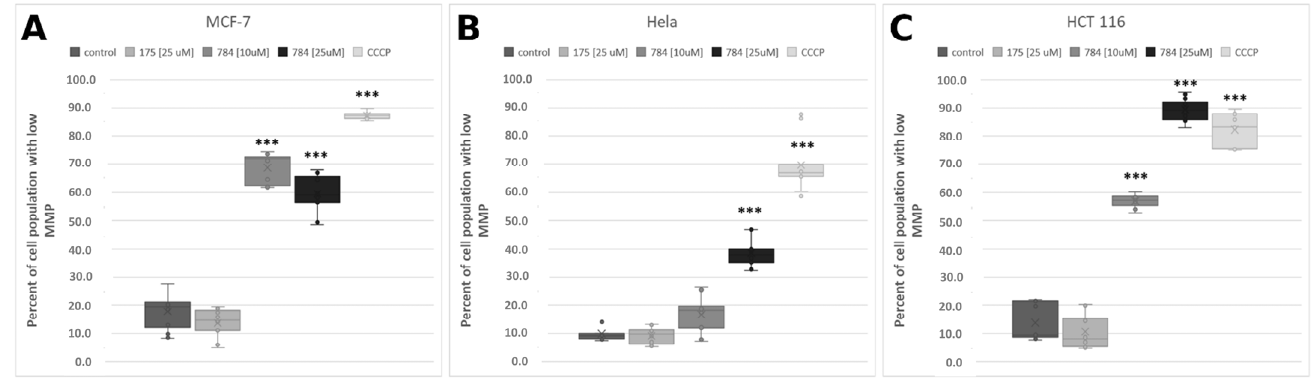
Figure 9. Changes of mitochondrial membrane potential in ( A ) MCF-7, ( B ) HeLa, and ( C ) HCT-116 cells treated with 24 (10 μ M or 25 μ M) or 31 (10 μ M) for 72 h. MMP analysis was performed using 25 μ M JC-1 staining for 30 min before the end of 72 h treatment period. As a low MMP control, 15 min CCCP-treated cells (100 μ M) were used. Results represent the mean of number of cells with low MMP (low JC-1 fluorescence) ± SD (n = 9) (*** p < 0.001).